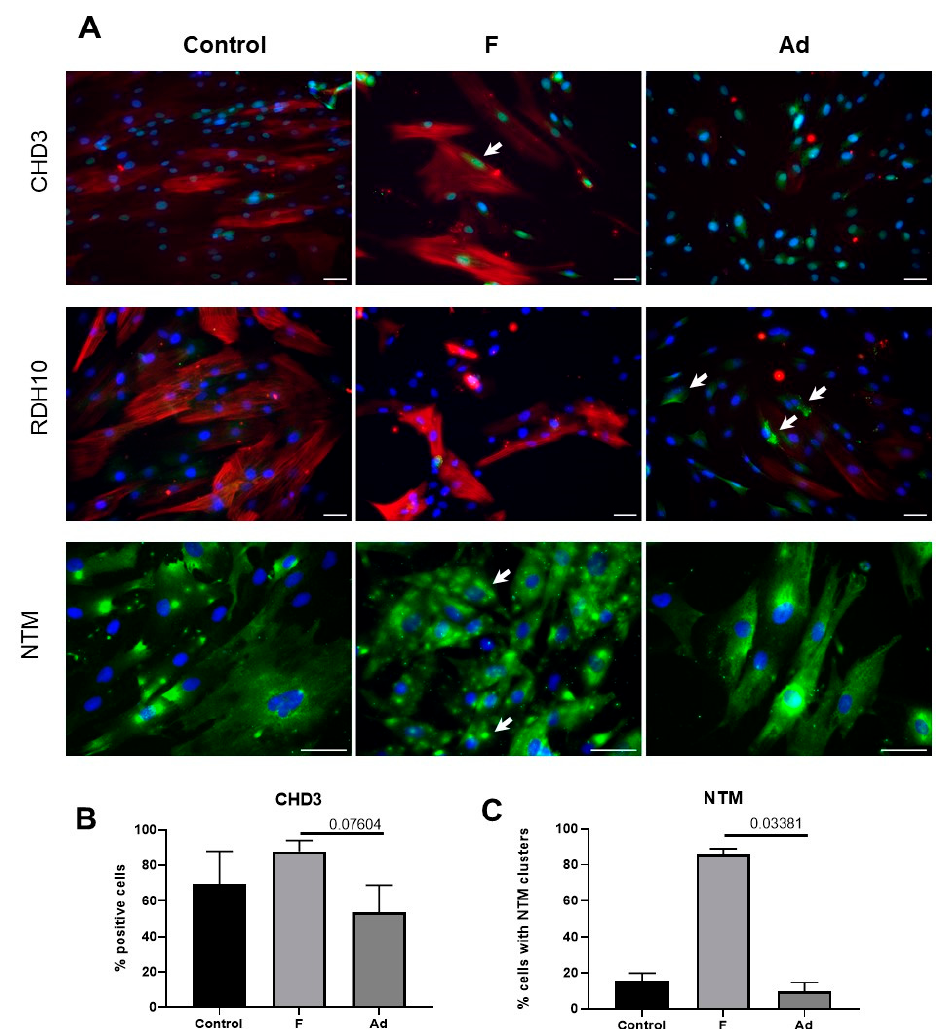
Figure 4. Immunocytochemical evaluation of CHD3 (green), RDH10 (green), NTM (green), and α SMA (red) in the control (Control) MSCs and after incubation in profibrotic (F) or adipogenic conditions (Ad). Fluorescent microscopy, blue staining—nuclei stained with DAPI, scale bar is 50 µm ( A ). The percentage of CHD3-positive cells, mean ± SE, p value is indicated ( B ). The percentage of cells with neurotrimin clusters, mean ± SE, p value is indicated ( C ).